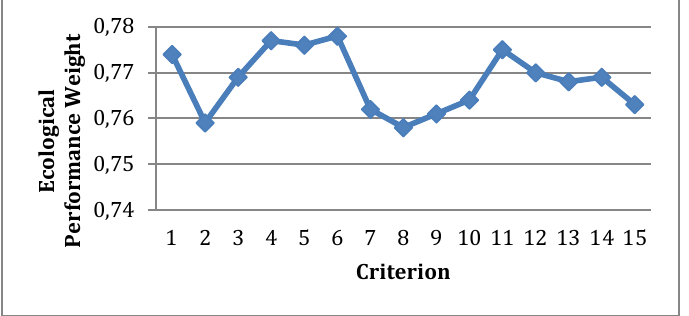
Source : Jiang, Ding, Zhang, Cai & Liu (2019)